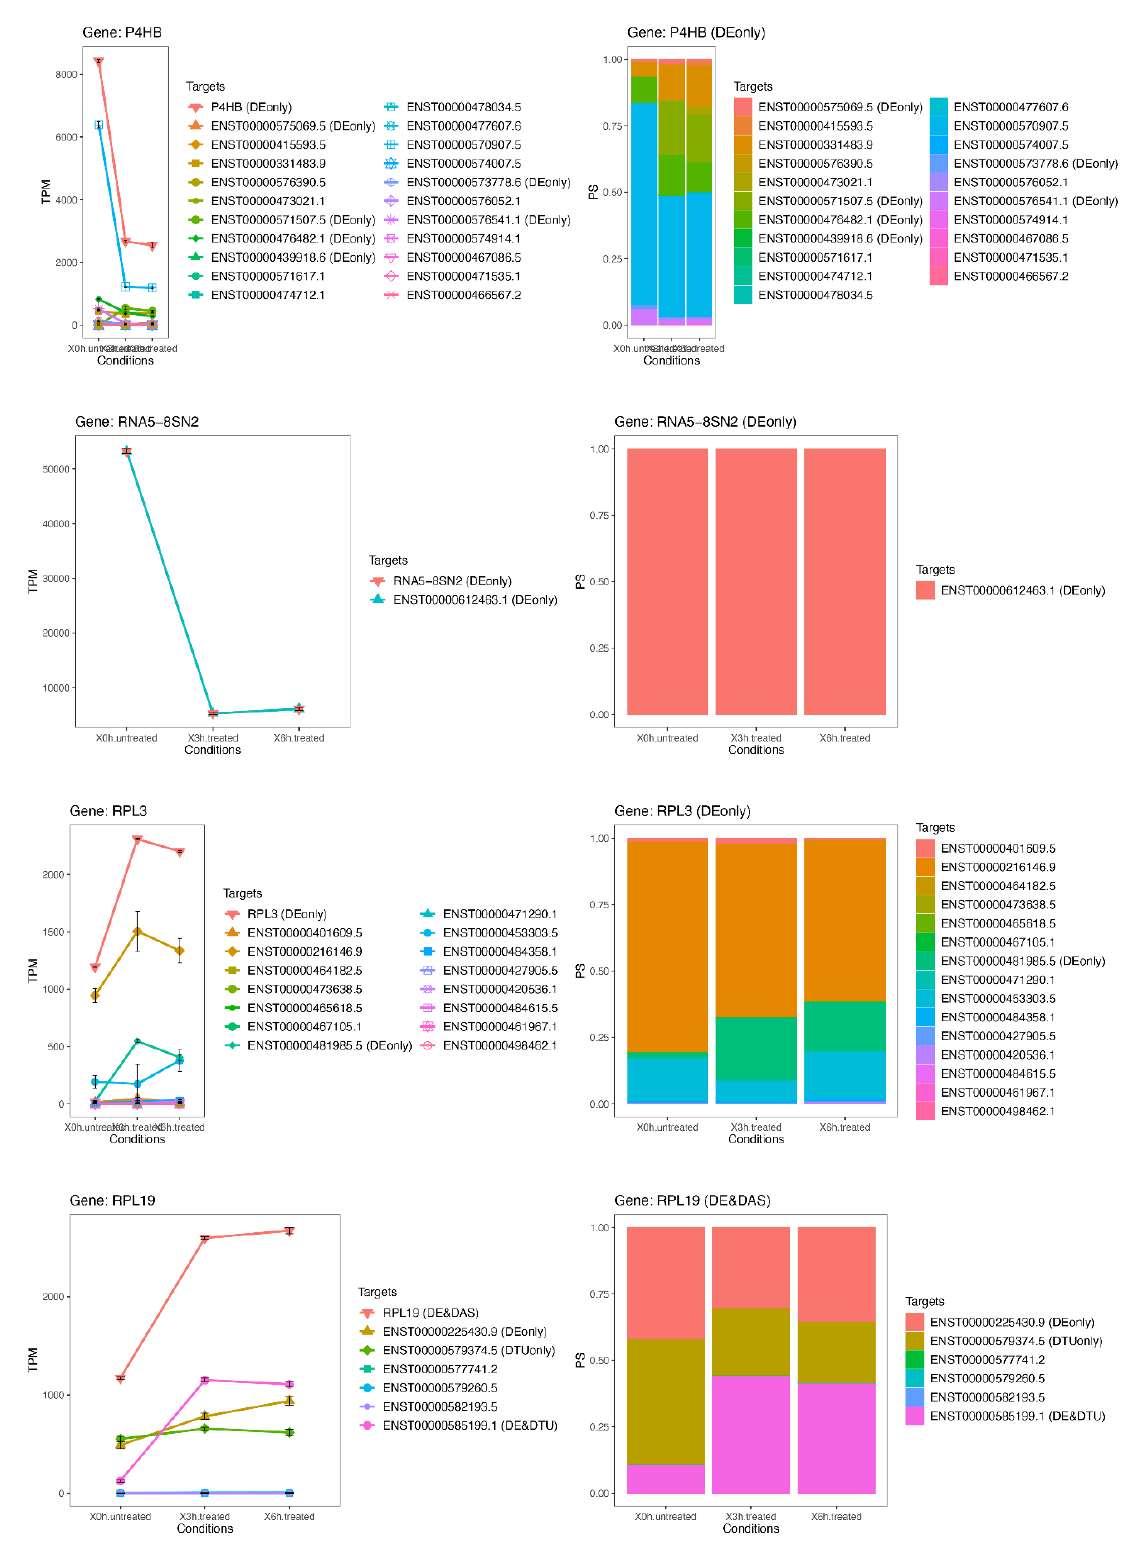
Figure 7 . Expression profiles of most important DE genes/transcripts; first cluster associated with newly discovered pathways linked to oxidative stress. Detailed gene/transcript expression profiles across the time course of the first cluster of most important DE genes (ACTG1, CAPZB, CCN2, FTL and RPS11) linked to newly identified candidate pathways linked to oxidative stress.